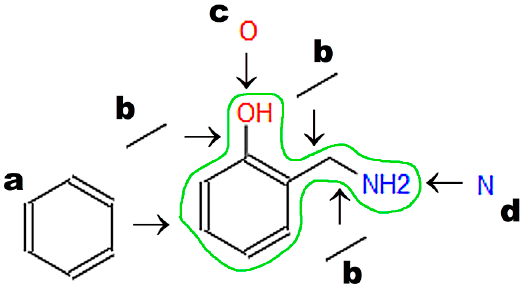
Figure 2. Graphic representation of molecular structure developed in the JSME editor (Basel, Swizerland) [74], which is available on the Chemical Structure Lookup website (National Institute of Cancer, Bethesda, MD, USA) [25]. The letters denote basic primitives: ( a ) benzene ring; ( b ) single bond; ( c ) oxygen atom; ( d ) nitrogen atom.